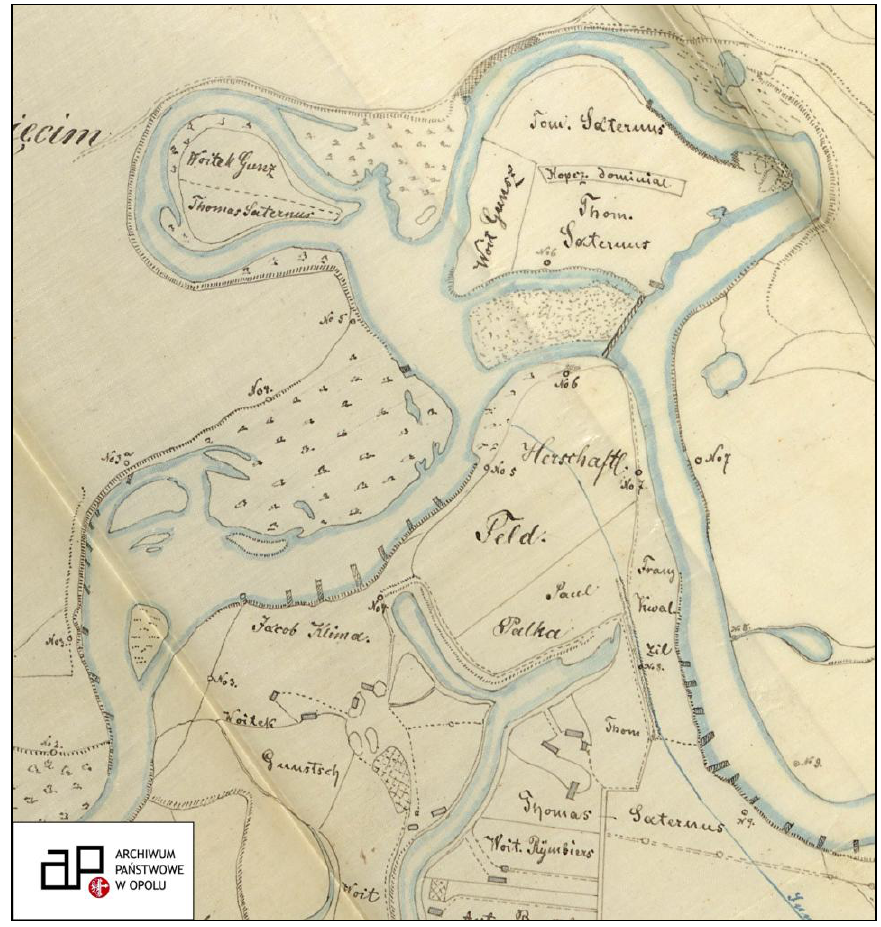
Fig. 2. Hydraulic structures in the River Vistula channel around the mouth of the River Przemsza – the arrangement